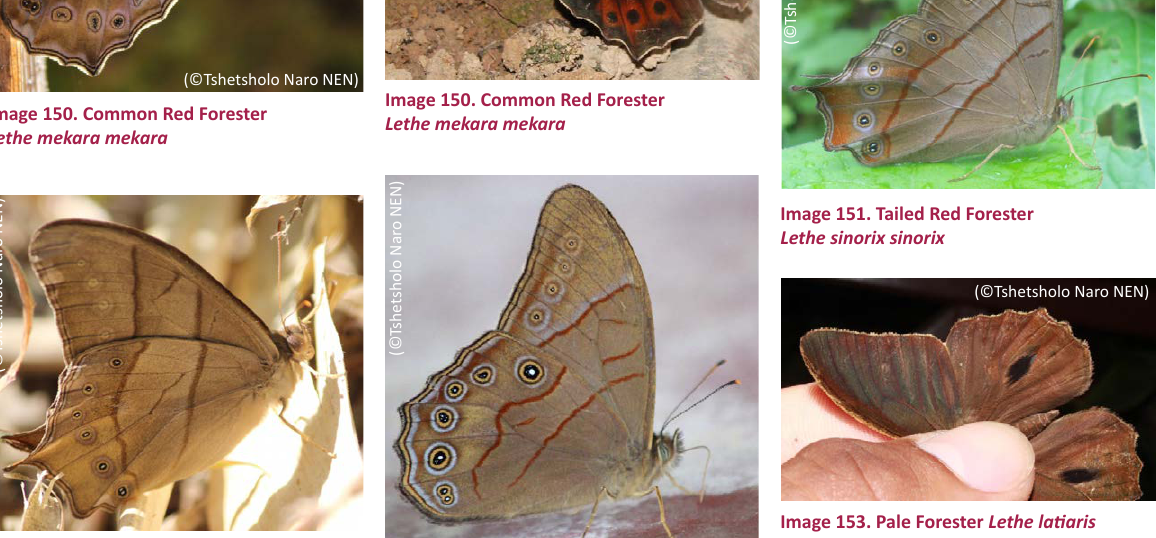
Image 152. Bamboo Forester Lethe cf. kansa